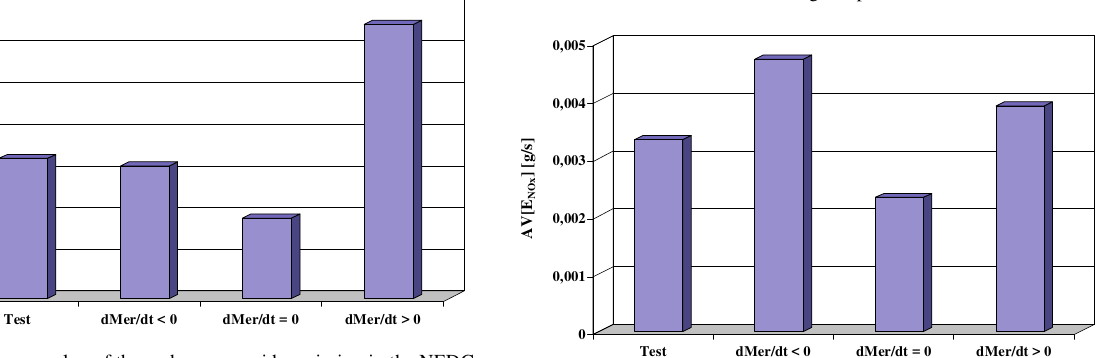
Fig. 20. The average value of the nitrogen oxides emission in the NEDC test and in the states corresponding to the negative, zero and positive time derivative values of the engine